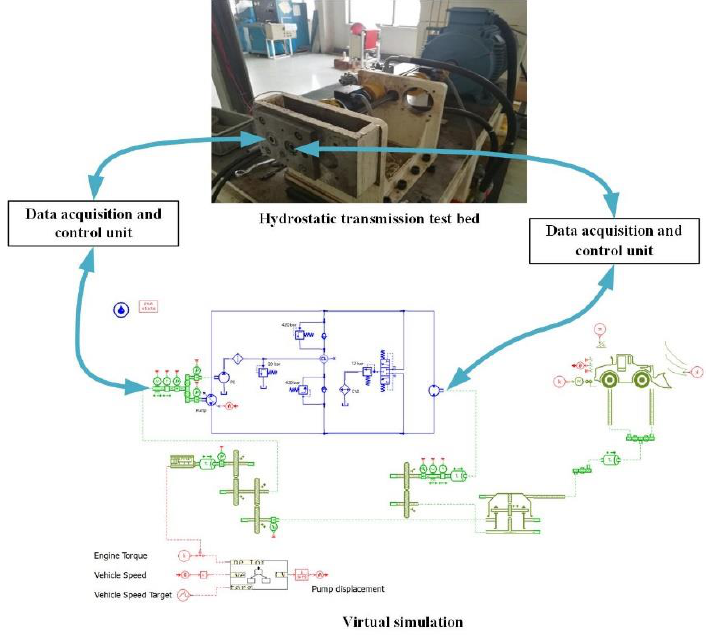
Figure 16. The diagram of co-validation of simulation and test.